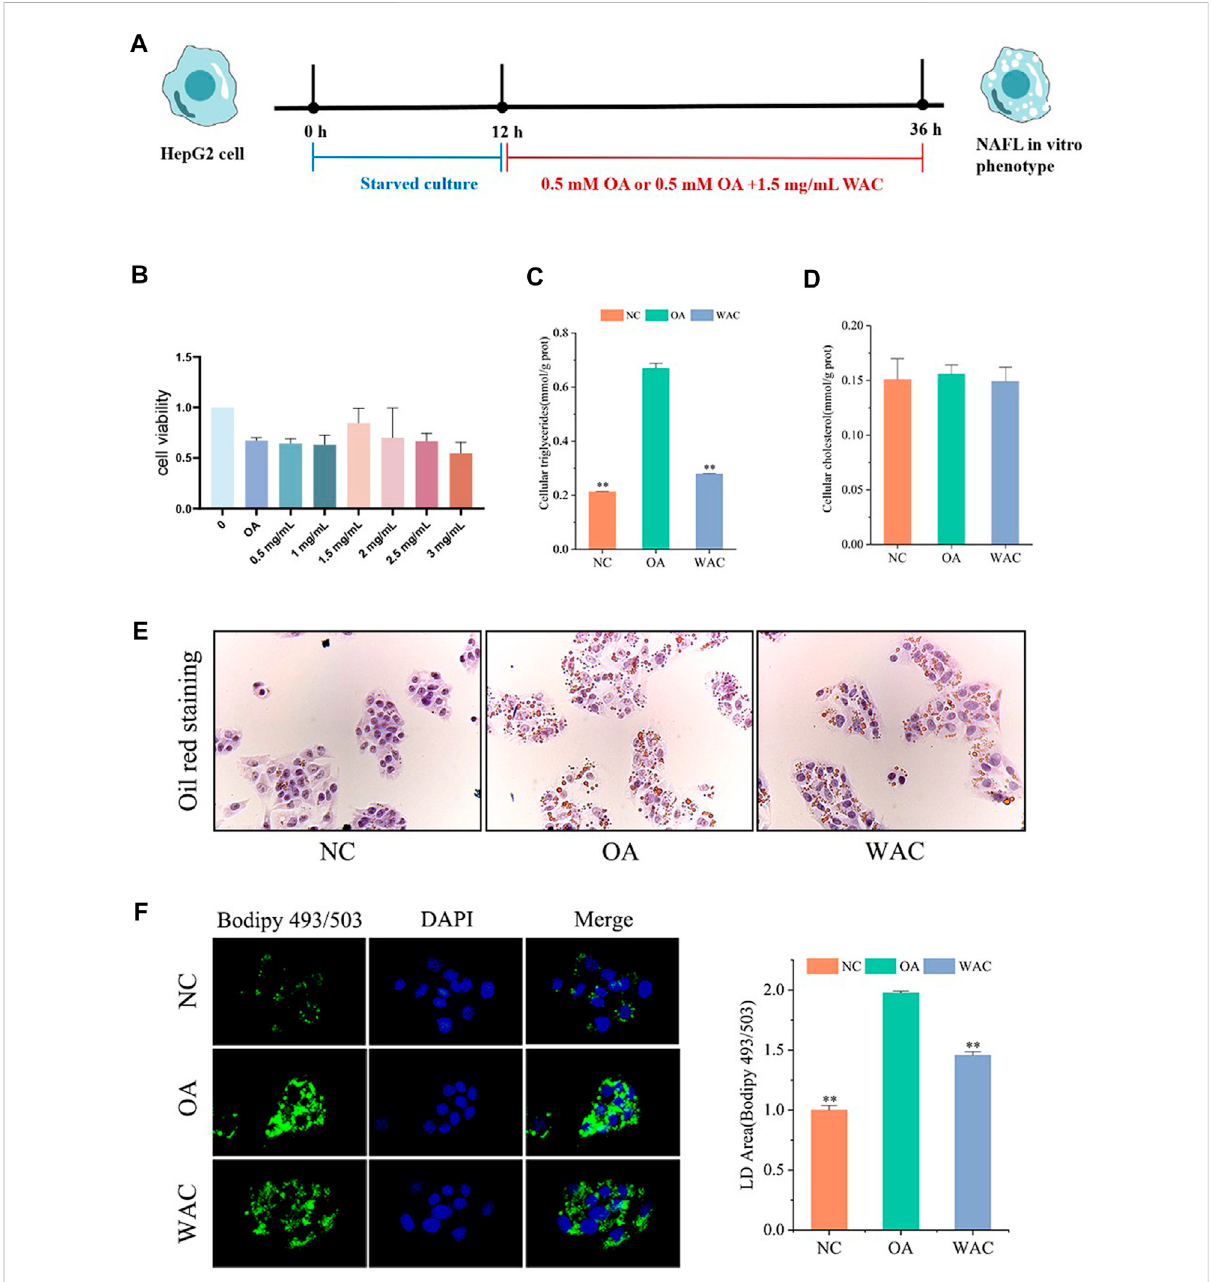
FIGURE 4 Effect of WAC on lipid accumulation in OA-induced HepG2 cells. (A) Cellular experimental procedures. (B) Cell viability. (C,D) Triglyceride and cholesterol levels in HepG2 cells. (E) Graph of oil red O staining results. (F) Graph of BODIPY staining results. Compared with OA, * indicates p < 0.05 and ** indicates p <